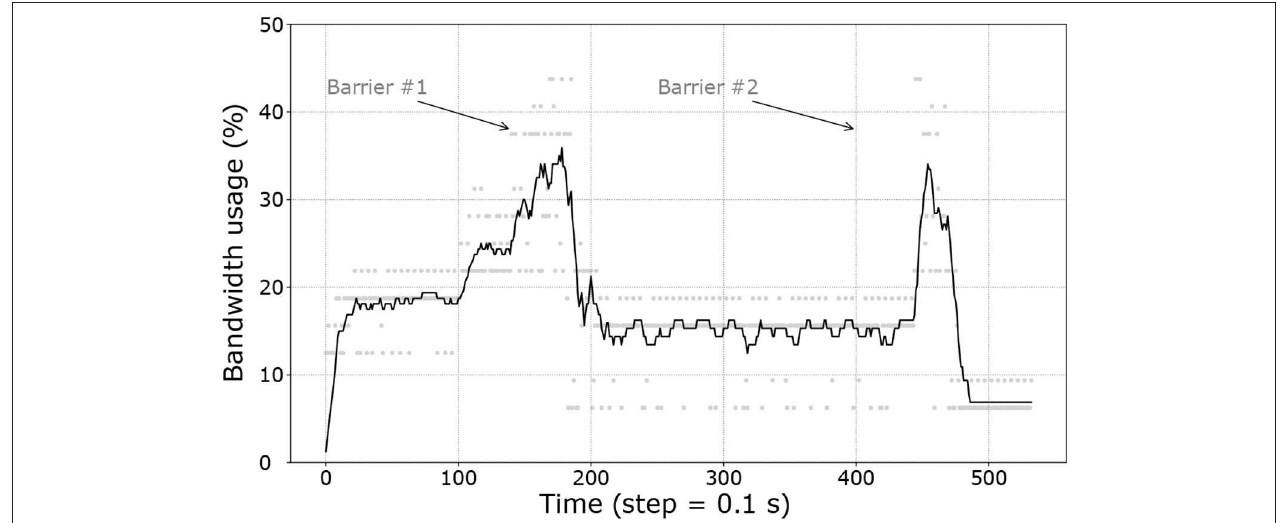
FIGURE 10 | Moving average of the bandwidth usage based on a window of 30 samples (which are represented by gray dots).